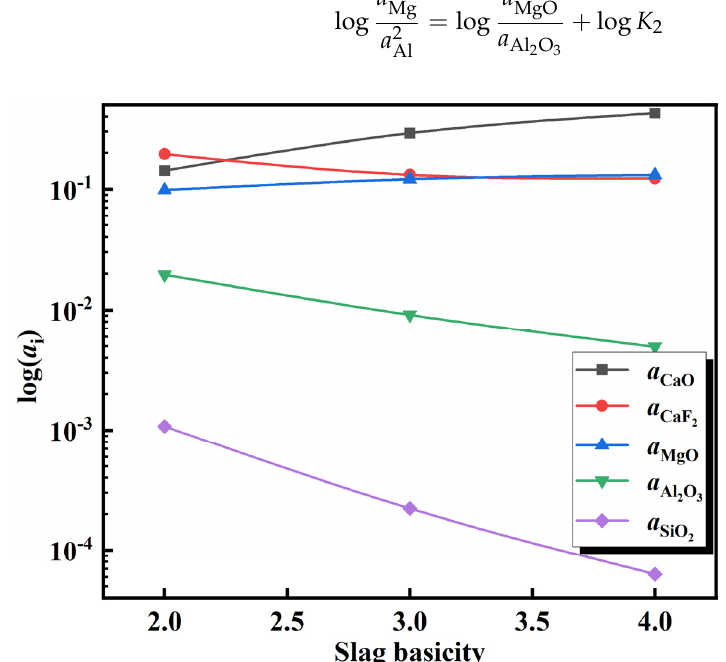
/ a Al ) on slag MgO 2 O 3